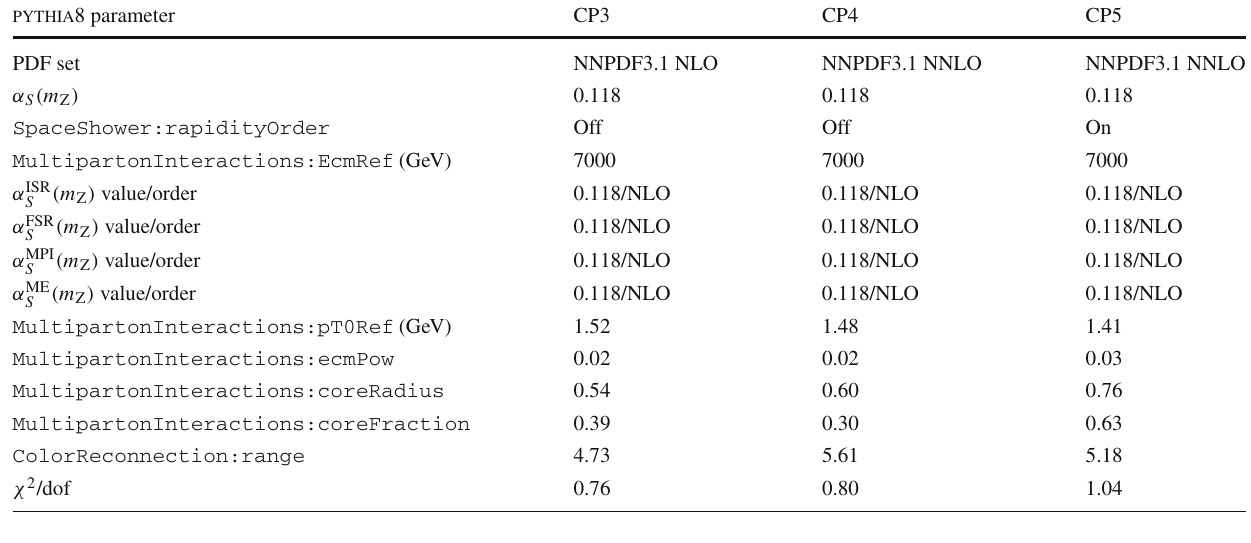
Schuler-Sjöstrand diffraction model [44] and also include the simula- tion of CD processes. The number of degrees of freedom for tunes CP3,